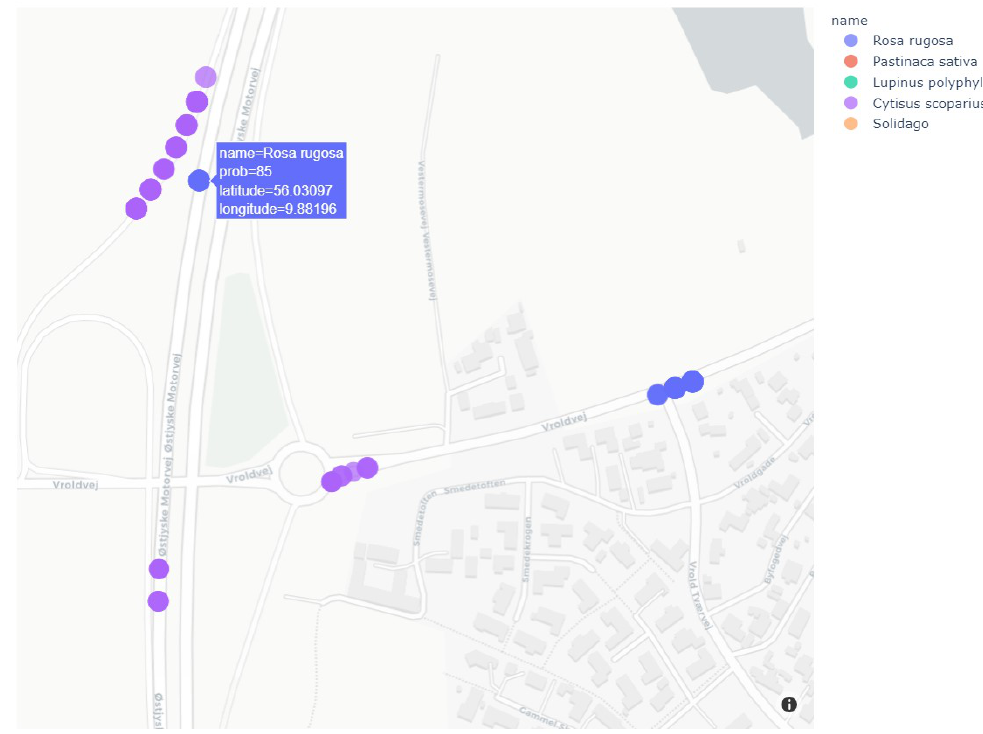
Figure 13. Zoom of location of invasive plants with information on map with a resolution of 1 s. between markers. (© OpenStreetMap